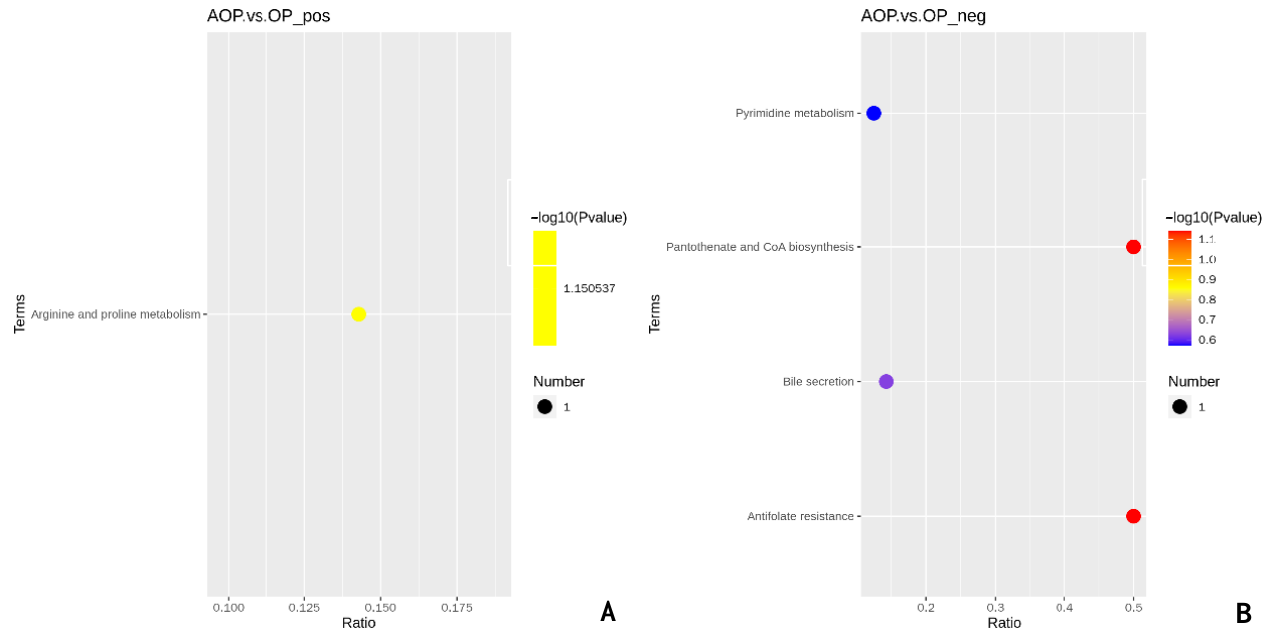
Figure 3. ( A ) KEGG metabolic pathway of AOP vs. OP in positive ion mode; ( B ) KEGG metabolic pathway of AOP vs. OP in negative ion mode. AOP represents the group fed a mixture of oat and alfalfa (n = 5). OP represents the group fed oat (n = 5).